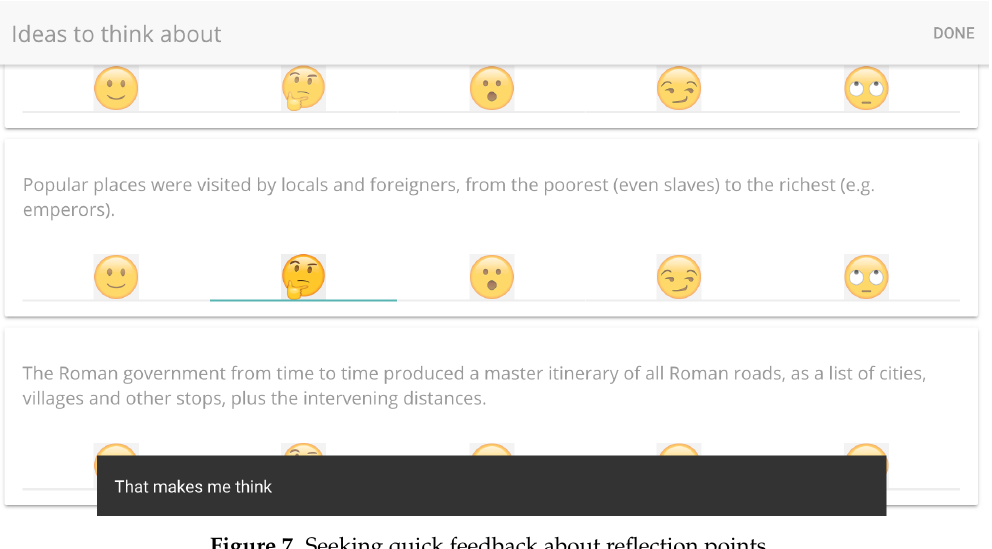
Figure 6. A multiple-choice question linked to a node of the mesh of associations.